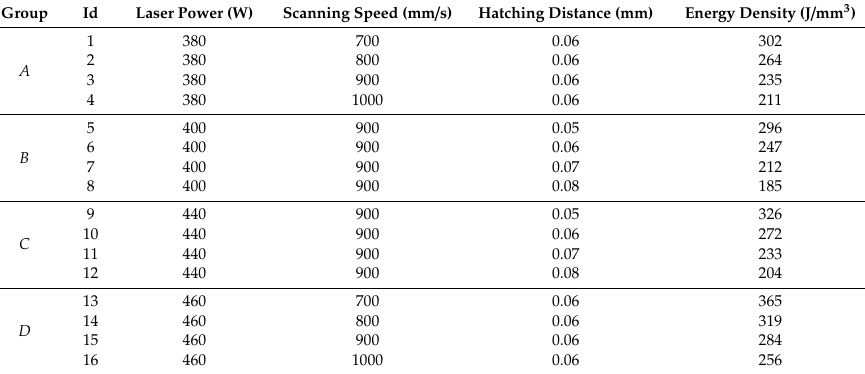
Table 1. Process parameters used in selective laser melting